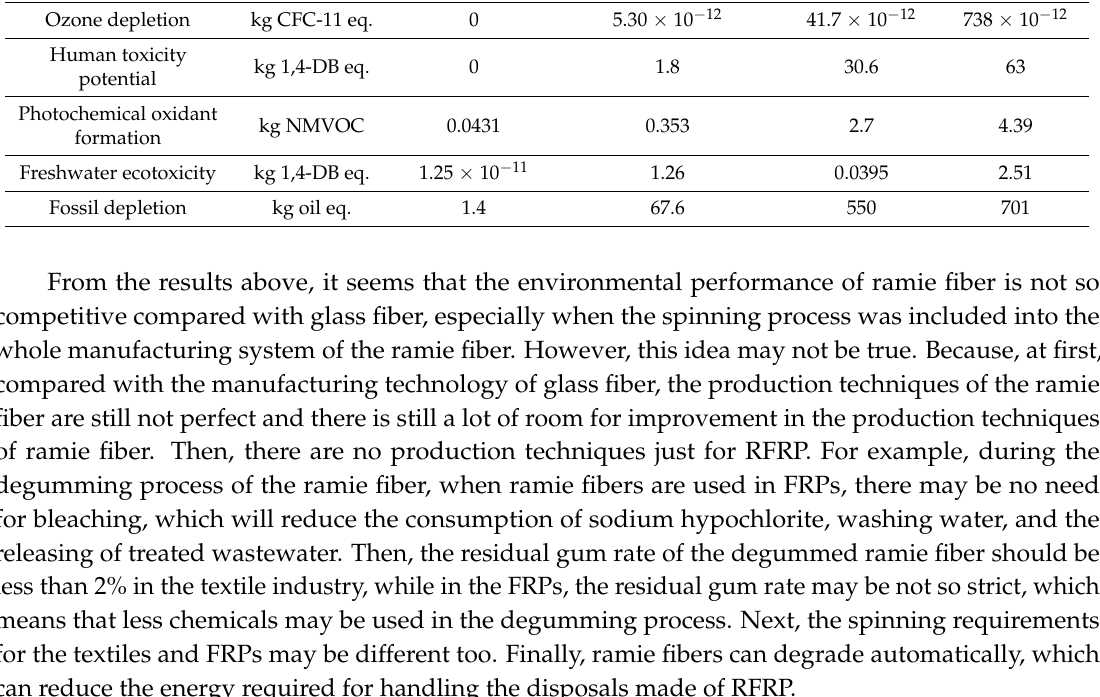
Cultivation, Carding and Harvesting and Spinning Peeling